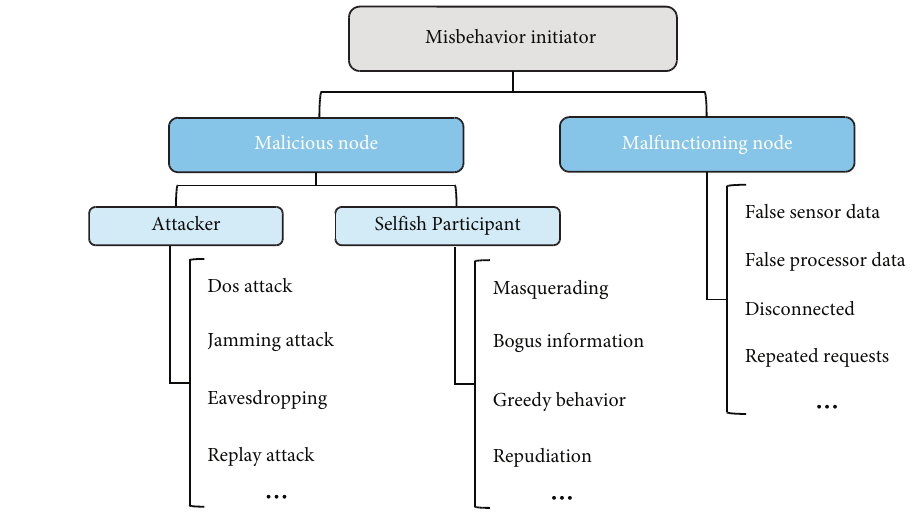
Figure 3: Classifications of misbehavior initiator.